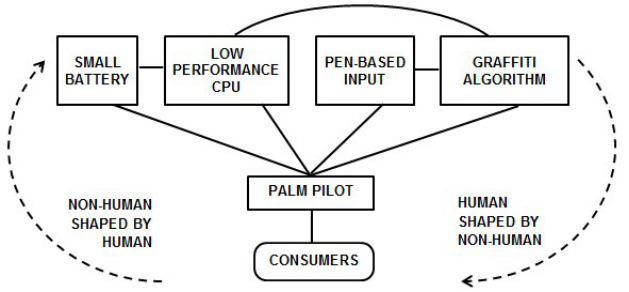
Fig. 3. Simplified chains of associations established during the development of Palm Pilot, to illustrate the spread of influences between humans and